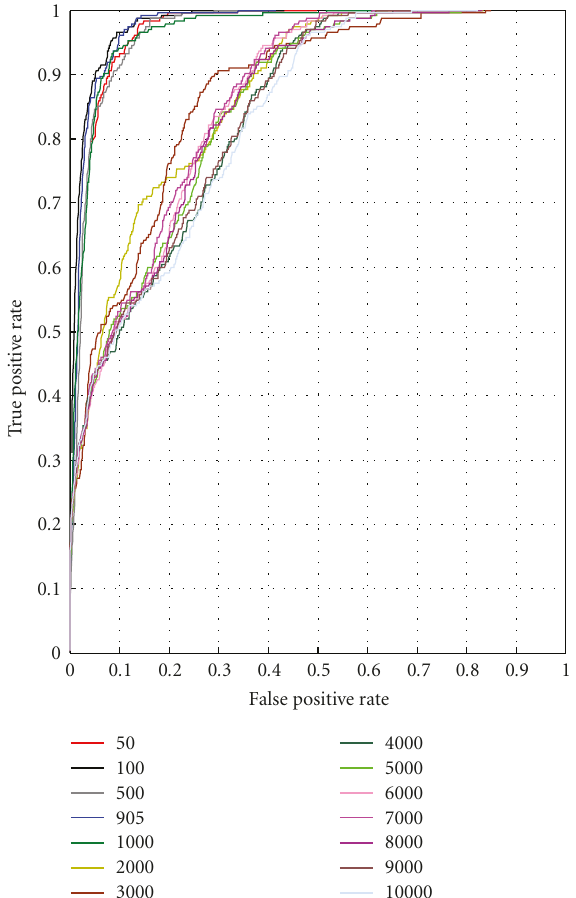
Figure 4: σ selection for ARES1D image. E ff ect of bandwidth on SVDD performance. The highest performance is achieved when σ ≈ 905; σ was incrementally varied from 50 →